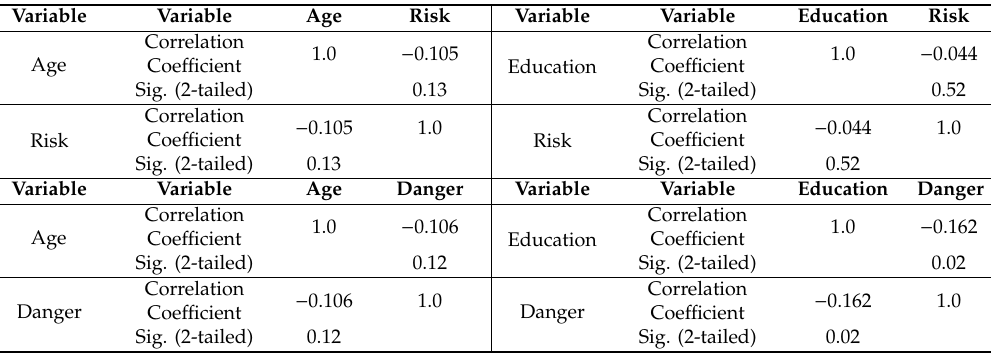
Table 6. Ranks and statistics of Age and Education / Risk and Danger ( n =